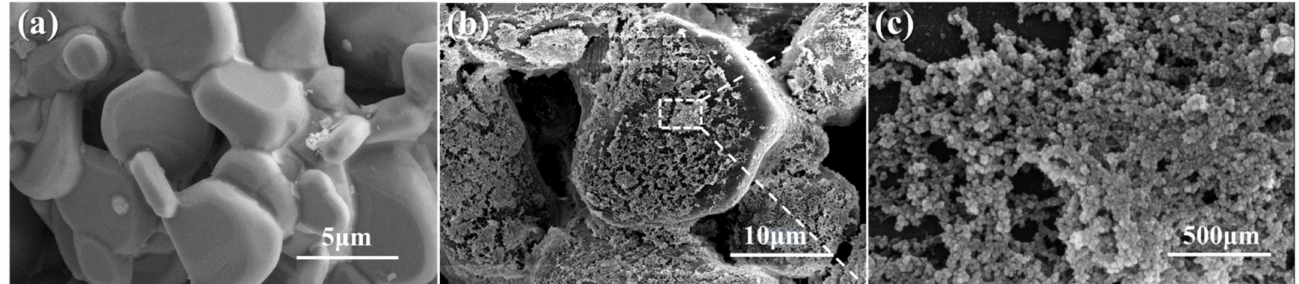
Figure 3. Surface morphology of the Al 2 O 3 support ( a ), the microstructure of the ZrO 2 membrane prepared using the in situ hydrothermal reaction on the support ( b , c